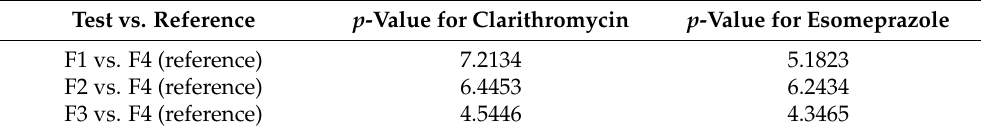
Table 8. Paired t -test